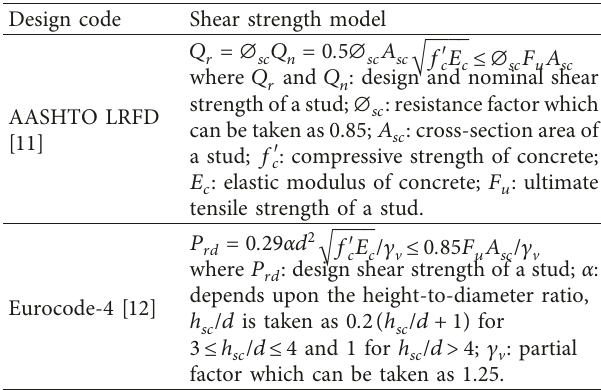
Figure 5: Postinstalled anchor bolts and filler. Table 3: Design static strength of a stud shear